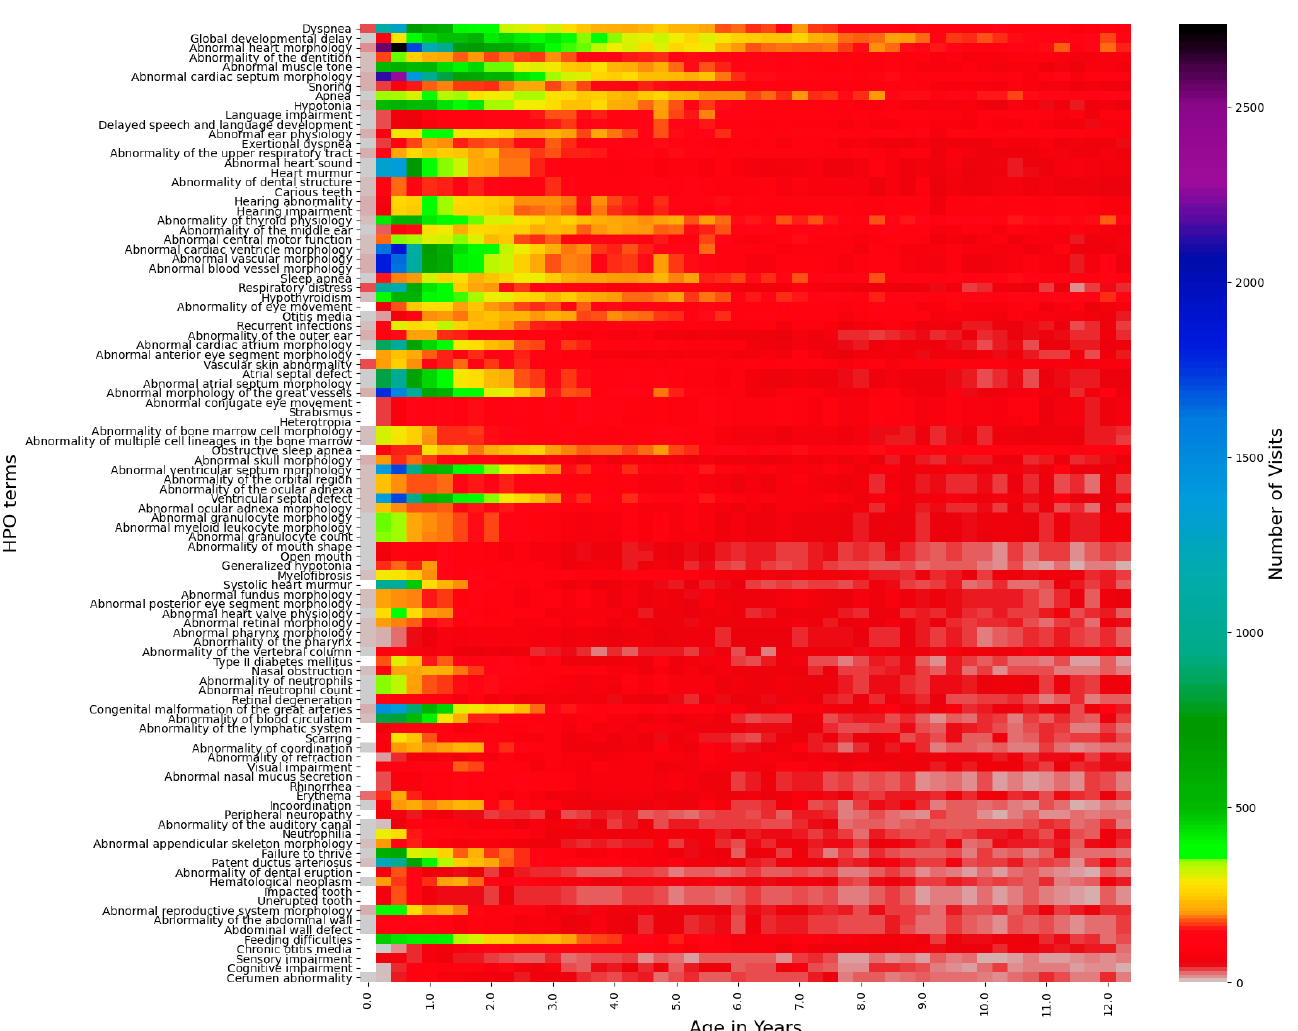
Figure 2. Top 100 HPO terms age distributions for the Down syndrome cohort. The number of visits with a certain age within a 3-month bin is represented by the color bar on the right, the top 100 HPO terms are listed on the left-side y -axis, and the age in years from 0–12.5 is listed on the x -axis.